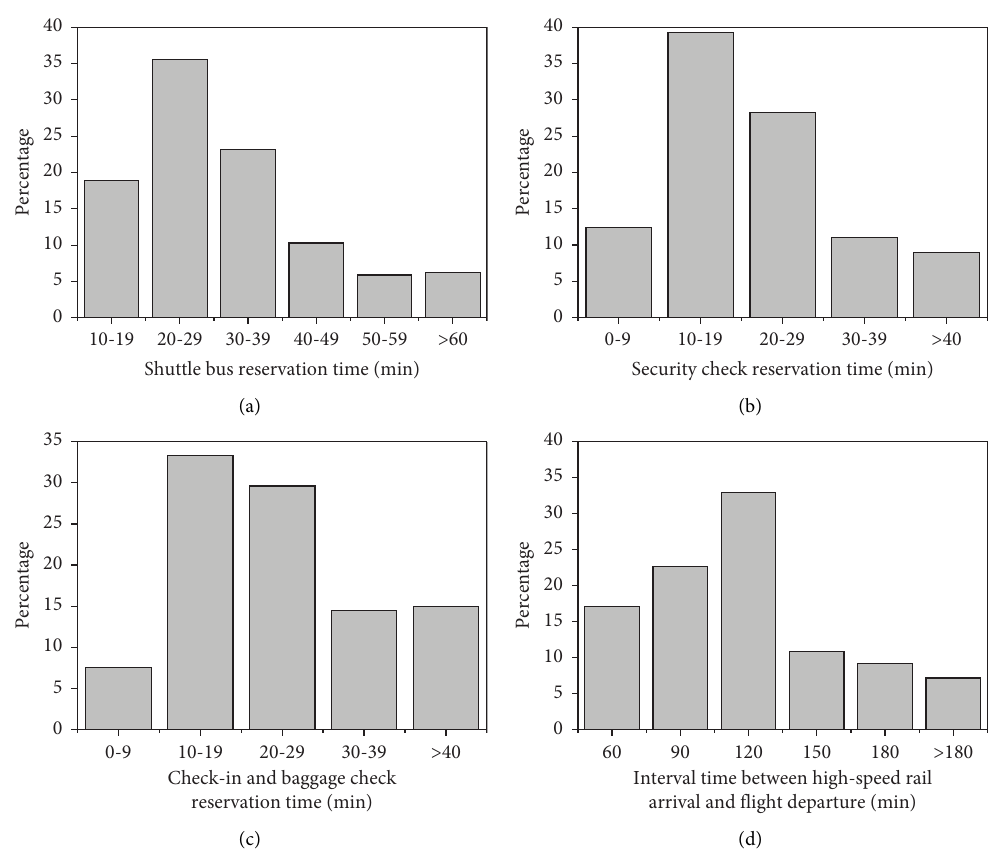
Figure 3: Reserved time distribution of each link of ARIS and interval time between high-speed rail arrival and fight